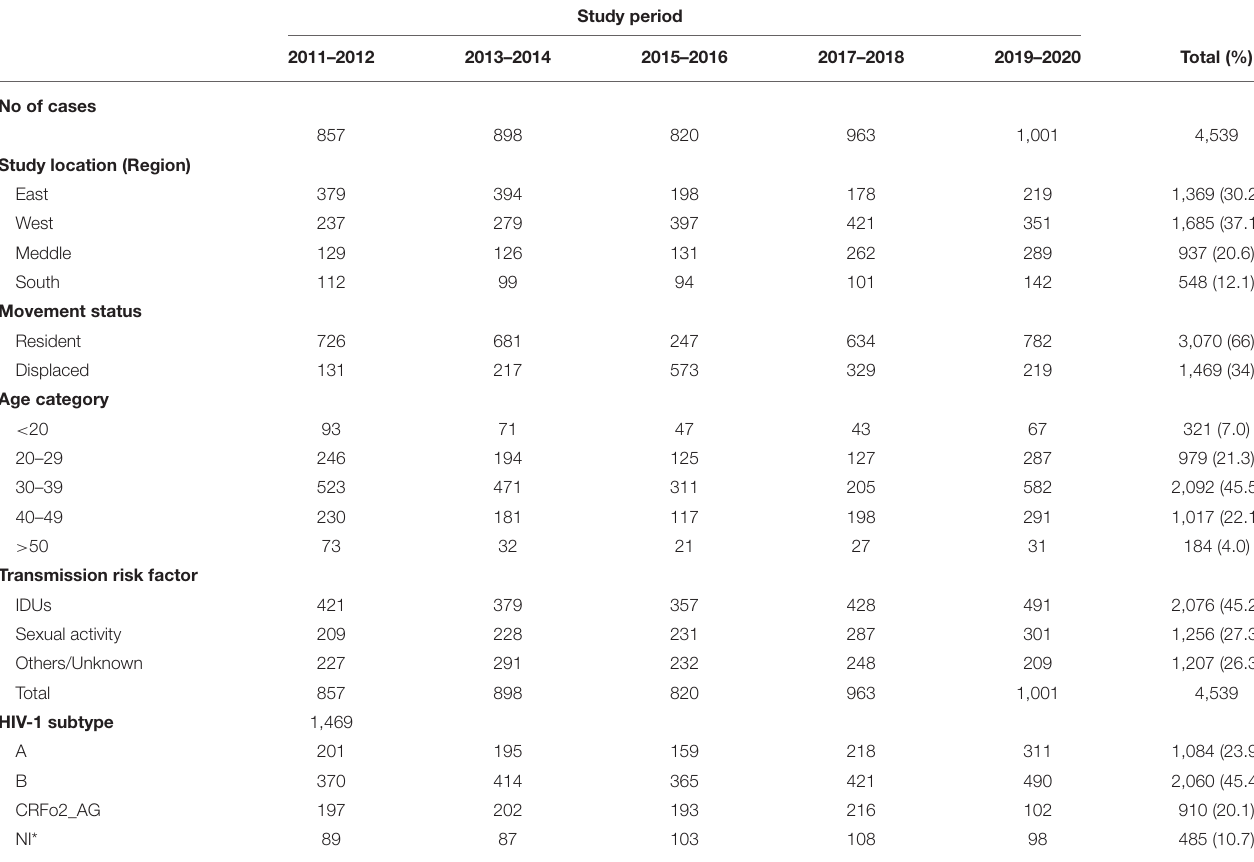
TABLE 2 | Demographic characteristics of HIV infected population during the Libyan armed conflict of